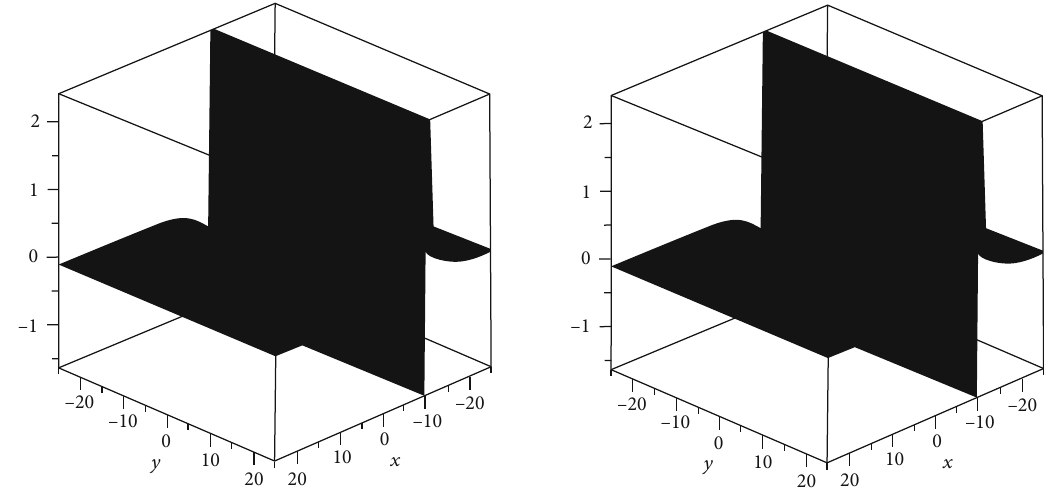
Figure 8: Graphical view of the exact and analytical solution for J ð ζ , ρ Þ at δ = 1 of system 2 .